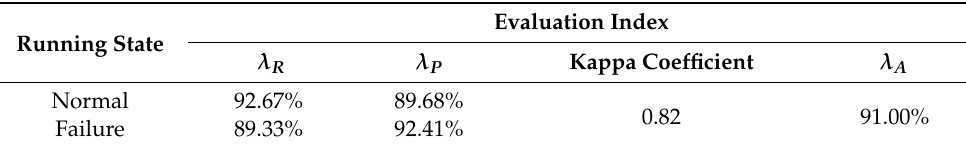
Table 3. Evaluation indexes of EEMD-MPA-KELM